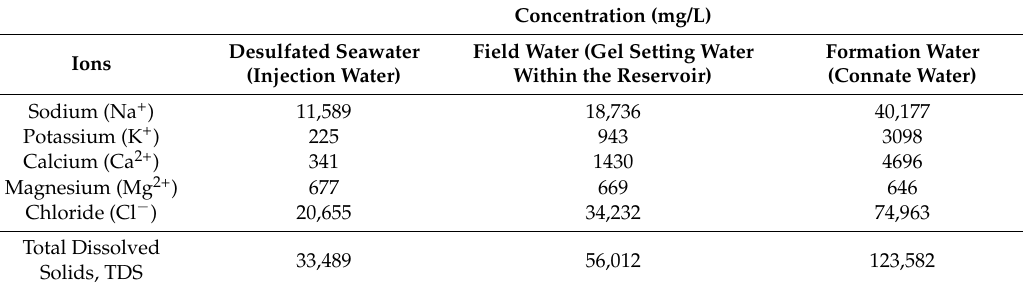
Table 4. Composition of typical oilfield